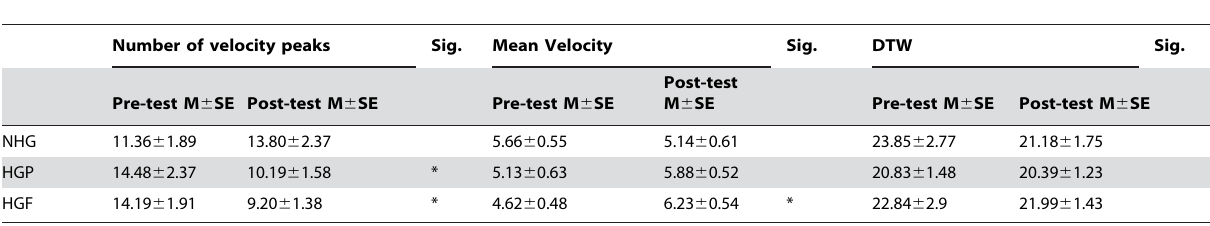
Table 2. Summary of raw data of Experiment 2 (mean 6 SE).